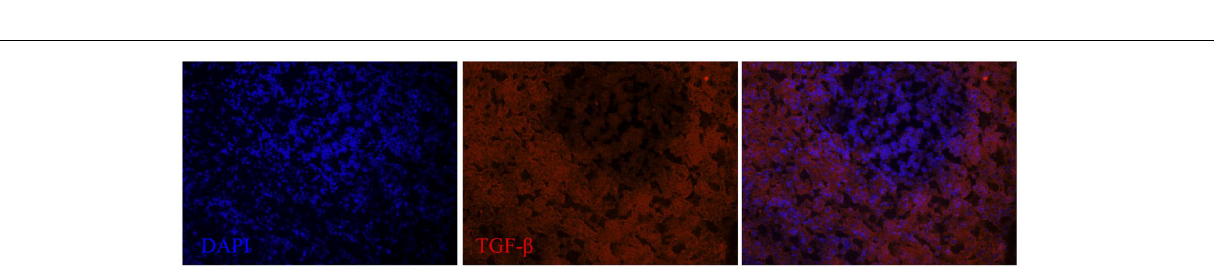
FIGURE 6 |TGF- β expression in the spleen of a dolphin with hyperinsulinemia . Dolphin splenic tissue sections were incubated with primary anti-human TGF- β , followed by nuclear staining usingVECTASHIELD mounting medium with DAPI. Original magnification 20 ×